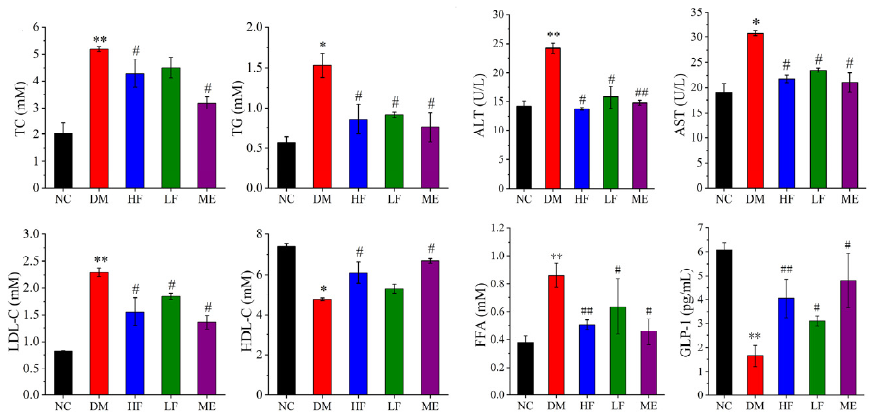
Figure 2. Effect of LJF on lipid-related indicators in T2DM mice, including TC, TG, ALT, AST, LDL-C, HDL-C, FFA, and GLP-1. * p < 0.05 and ** p < 0.01 vs. NC group, and # p < 0.05 and ## p < 0.01 vs. DM group.